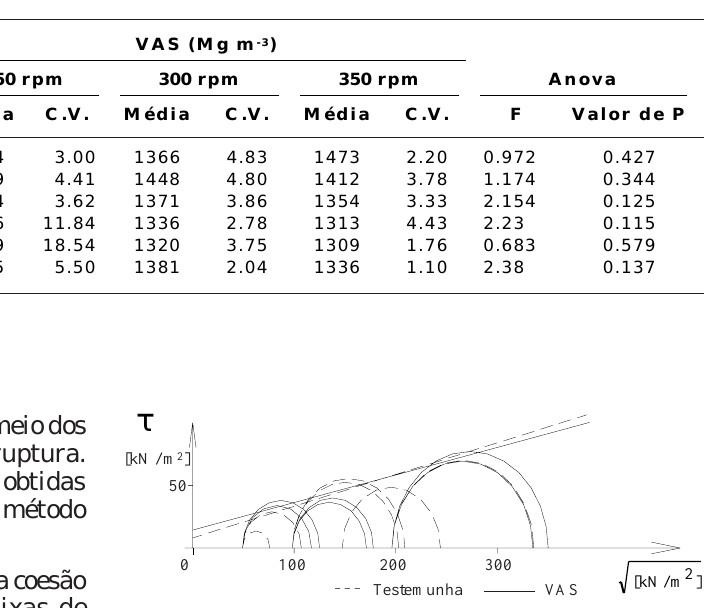
Figura 6. Círculo de Mohr, referente aos ensaios triaxiais para profundidade de trabalho de 0,30-0,60 m.